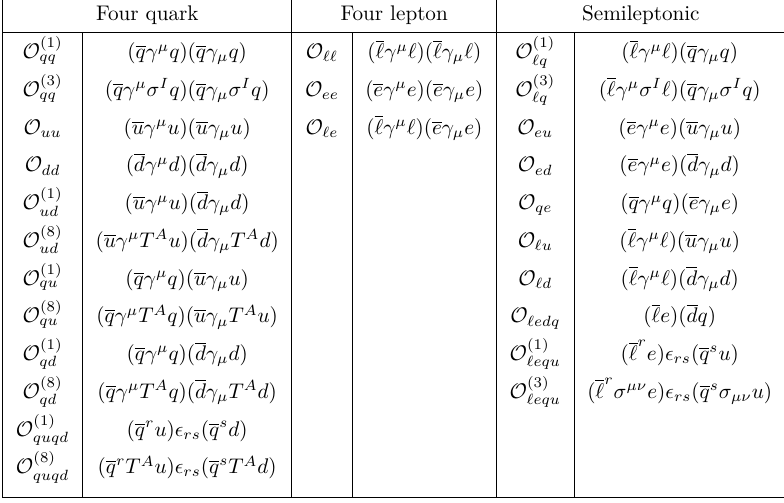
Table 9 . SMEFT four-fermion baryon number conserving